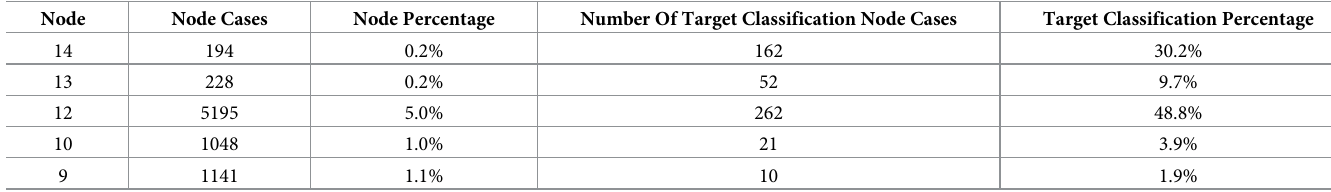
Table 1. Extremely long intervals between insured and surrendered